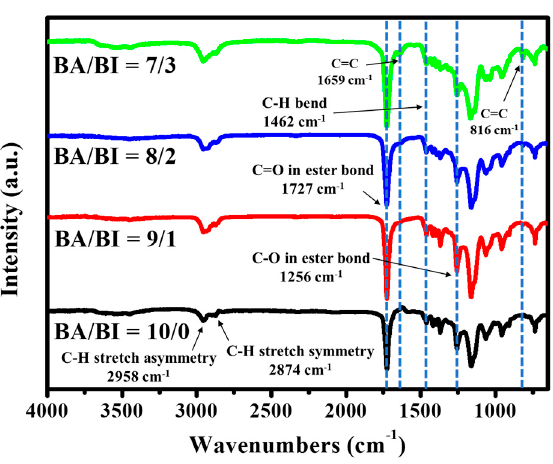
Figure 2. FT-IR spectra of the PBABI copolyesters.